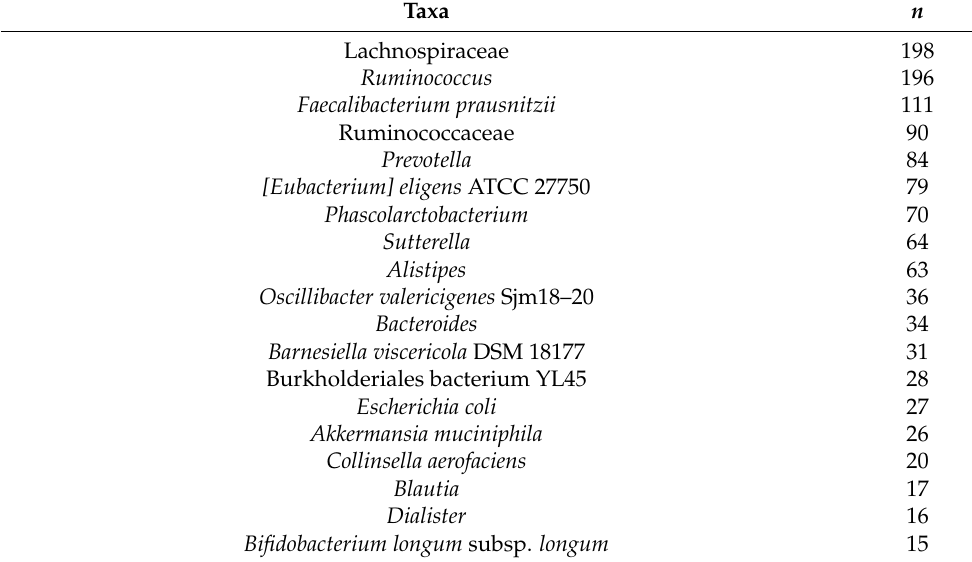
Table 2. Number of metagenome-assembled genomes (MAGs, n = 1361) recovered from the micro- biota of healthy individuals and assigned to taxonomic clades that were also found in the microbiota of patients with Crohn’s disease. MAGs were identified at family, genus, species or strain level. It should be noted that these common clades (total number of different taxa n = 41) were identical to those shown in Table